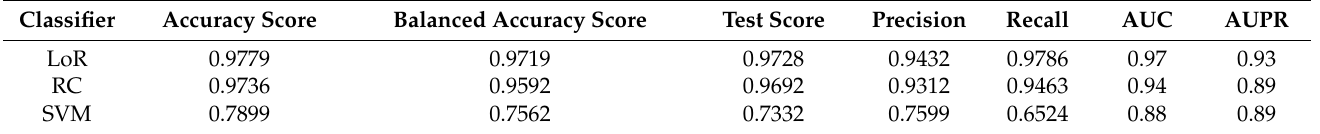
Table 4. Mortality prediction performance of various models for classification